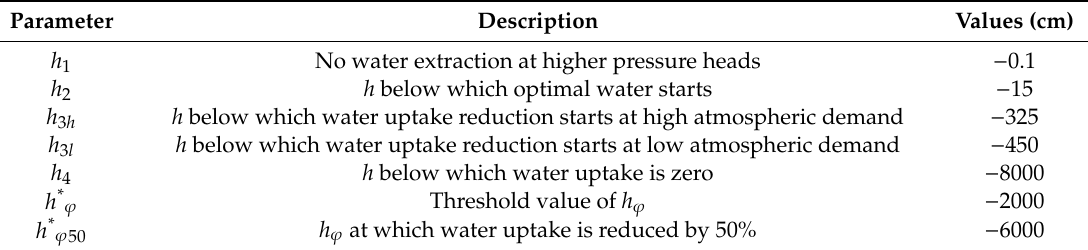
Table 2. Values of parameters in water and salt stress response